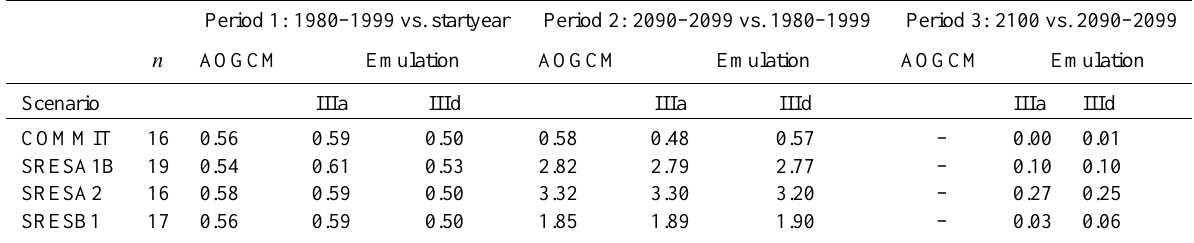
Table 3. Comparison of global-mean temperatures from AOGCMs and emulations for three periods. The means across all available CMIP3 AOGCMs for each scenario (number of available AOGCM datasets given in column “ n ”) are compared to the mean across the matching number of emulations using AOGCM-specific “like-with-like” forcings, denoted by “IIIa”. The emulations with parameter settings from calibration III (see text) and applying “full” forcing emulations, averaged across all 19 emulations, are shown for comparison (column IIId). On the notation: The three methods for calibrating carbon cycle and climate parameters (see Table 1) are denoted with roman numbers I, II and III, while the application of AOGCM-specific forcing settings is denoted by a small Latin character “a”, the application of standardized “full” forcings is denoted by “d” (with interim stages “b” and “c” being described in the companion paper Meinshausen et al., 2011, see Fig. 3